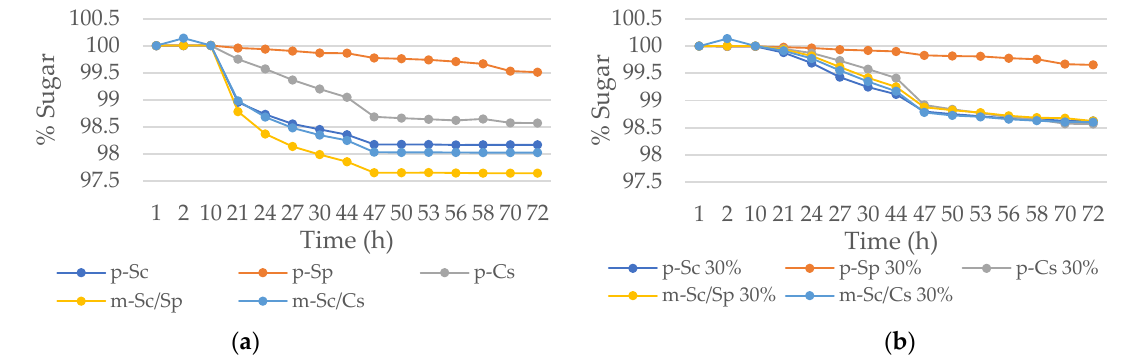
Figure 6. Fermentative kinetic of pure and mixed cultures of S. cerevisiae , C. stellata, and S. pombe in: ( a ) YNB + glucose medium and, ( b ) YNB + glucose + 30% sorbitol medium. Figure 6b corresponds to cited combinations but under high osmotic pressure media.